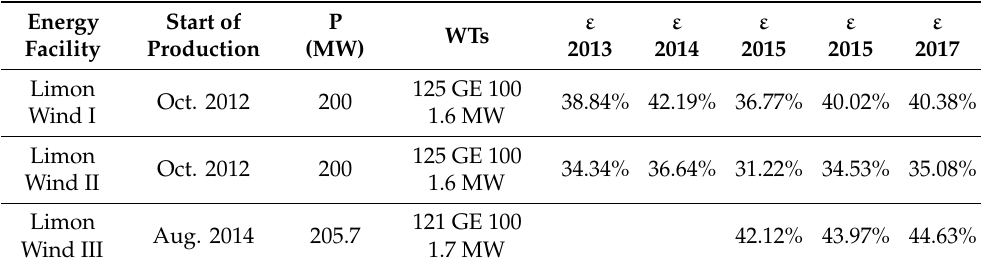
Table 4. Limon Wind Energy Center